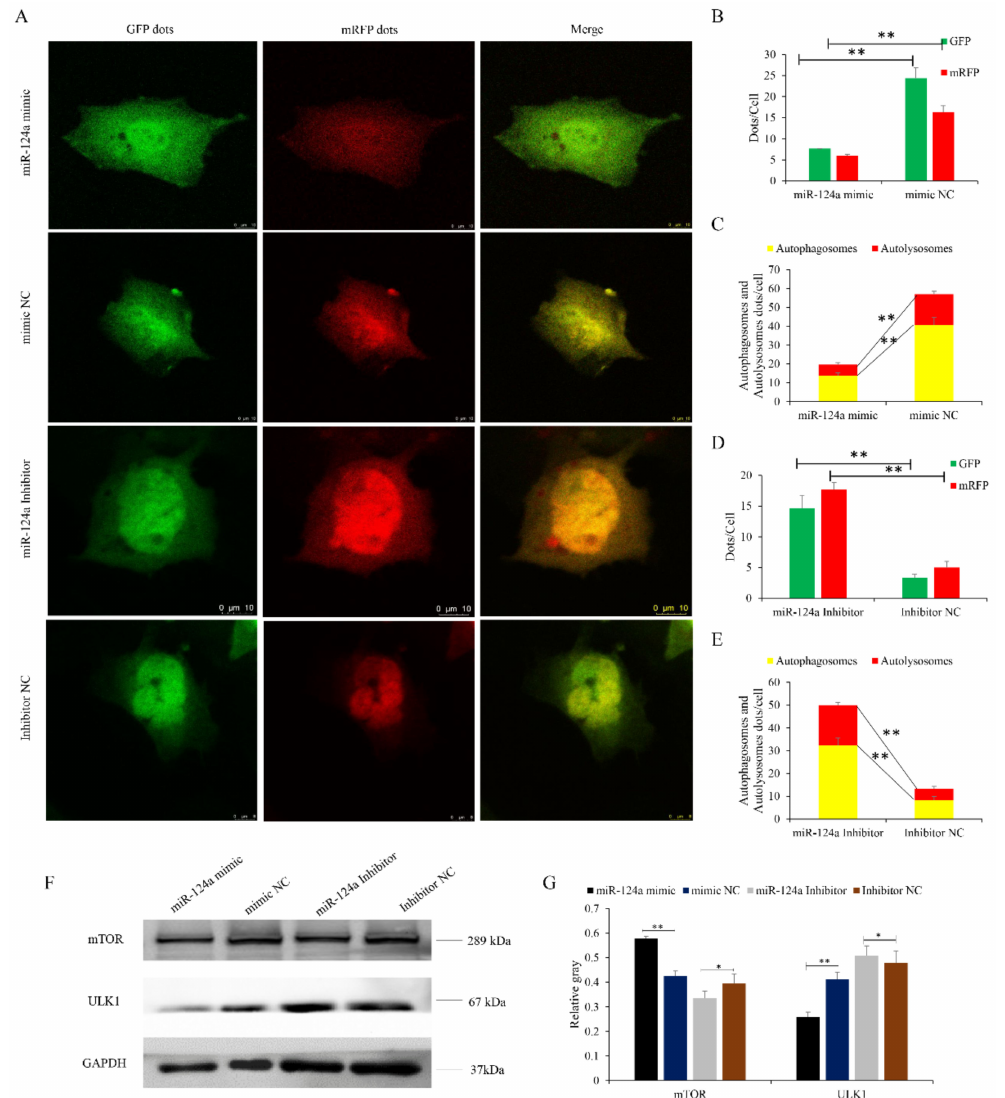
Figure 9. VMP1 promotes myoblast autophagy: ( A ) An adenovirus harboring tandem fluorescent mRFP-GFP-LC3 was used to evaluate the extent of autophagic flux after VMP1 overexpression or silencing. ( B , D ) Mean numbers of green and red puncta per cell; three cells were randomly selected from each field to be counted. ( C , E ) Mean numbers of autophagosomes and autolysosomes per cell. Autophagosomes contain both green and red puncta; in the merged images, the puncta appear yellow. Autolysosomes contain red puncta only. ( F , G ) Levels of ULK1/mTOR were detected after VMP1 overexpression or silencing. GAPDH was used as an internal standard. Replicates = 3. Data are presented as the mean ± SE; * p < 0.05 and ** p <